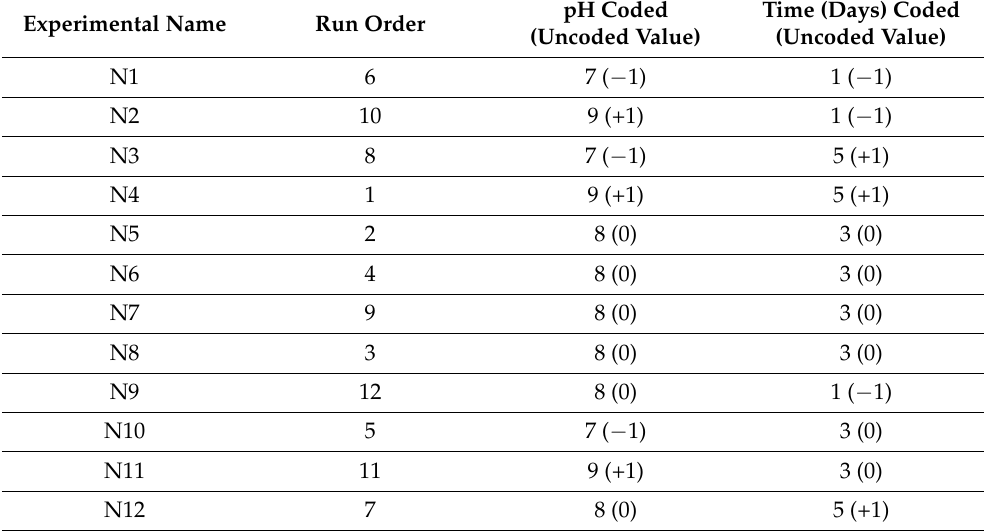
Table 1. Experimental Matrix Full Fac (three levels). It shows the experimental name, the order in which the experiments were run, and the values of the variables